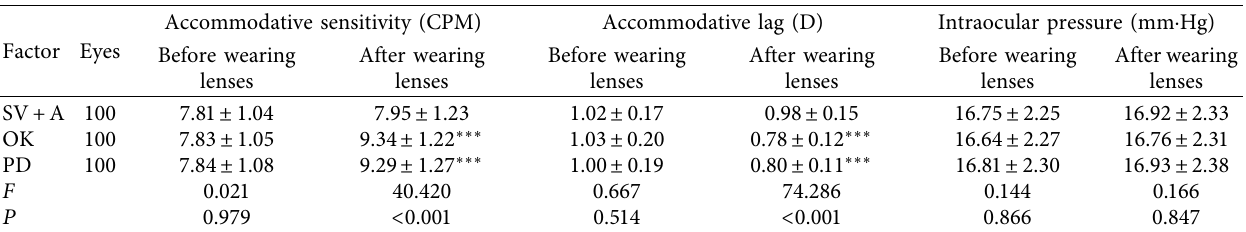
Table 4: Comparison of accommodation response before and after wearing lenses between the SV +A, OK, and PD groups. Factor